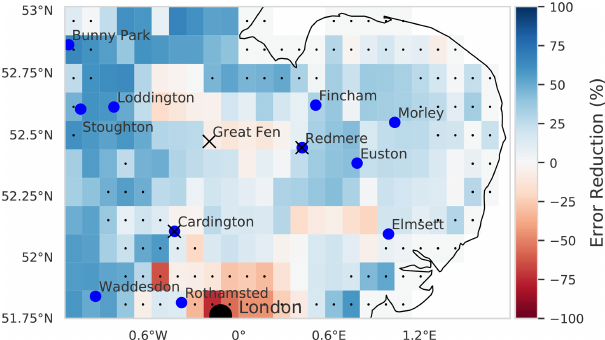
Figure 7. Map showing the difference between root mean squared error (RMSE) when JULES spatially aggregated estimates are com- pared to SMAP observations for the prior and posterior ensemble. Blue corresponds to reductions in RMSE for the posterior ensemble and red to an increase. Grid cells displaying stippling signify low- quality SMAP pixels, which have not been used in the assimilation procedure. Over the whole domain, we find an average reduction in RMSE of 20% after data assimilation for 2016 and 21% for